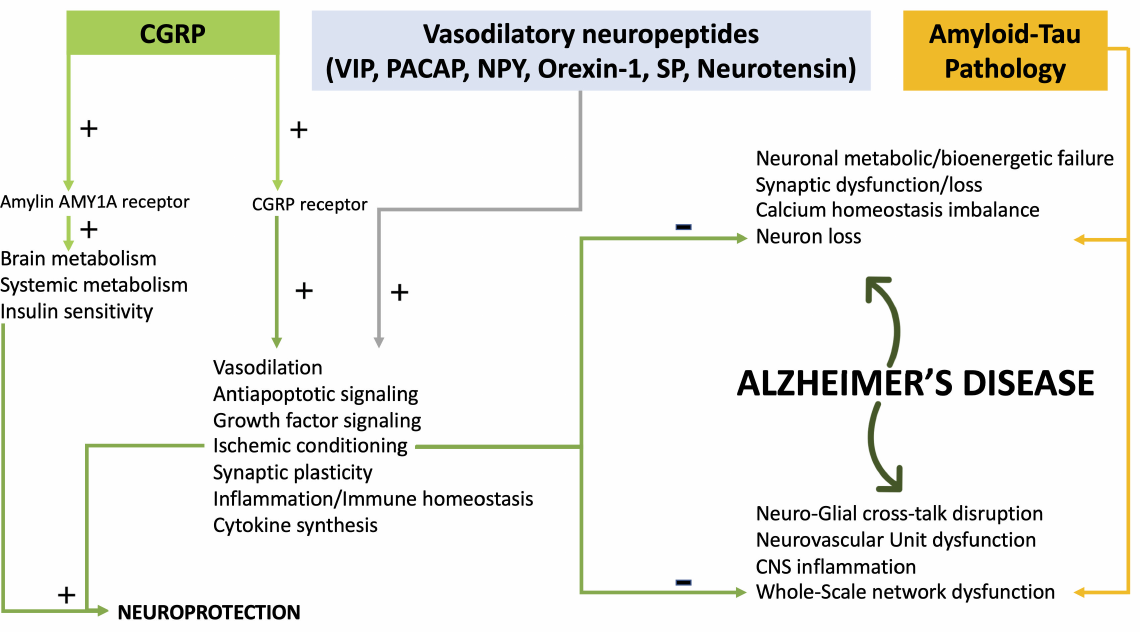
Fig.1. Synopsisofpotentialneuroprotectivemechanismsexertedbycalcitoningene-relatedpeptide(CGRP)andvasodilatoryneuropeptideson Alzheimer’s disease (AD)